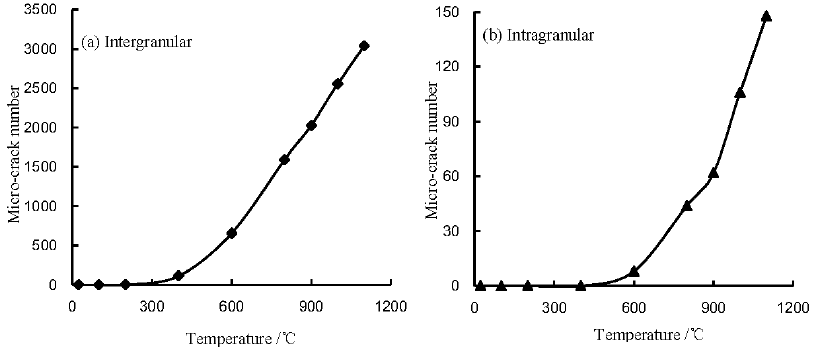
Figure 6. Micro-crack number varies with temperature: ( a ) intergranular; and ( b ) intragranular.